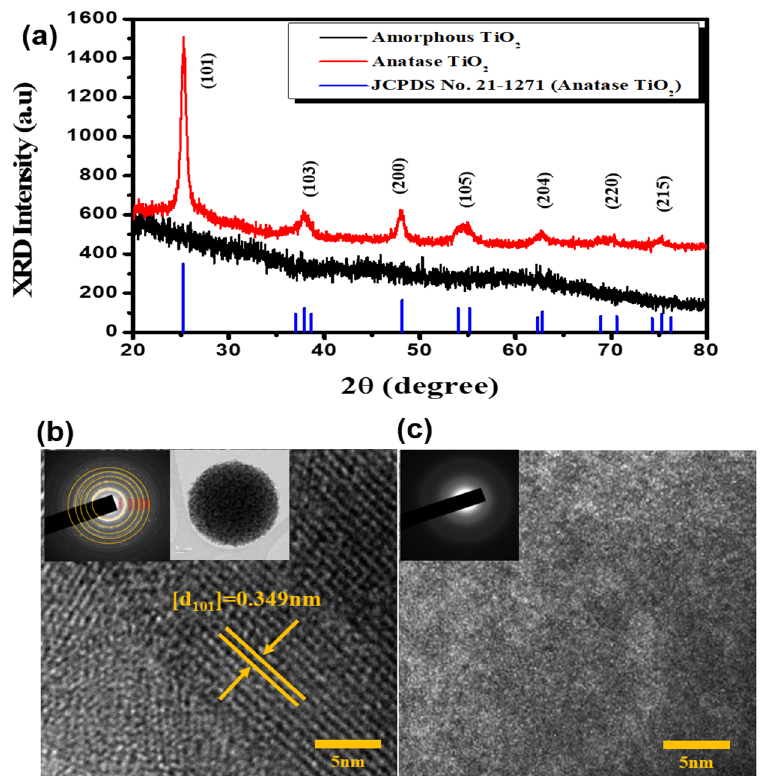
Figure 3. ( a ) XRD patterns of as-synthesized and thermally annealed TiO 2 NSs and HR-TEM images and SAED patterns of ( b ) anatase and ( c ) amorphous